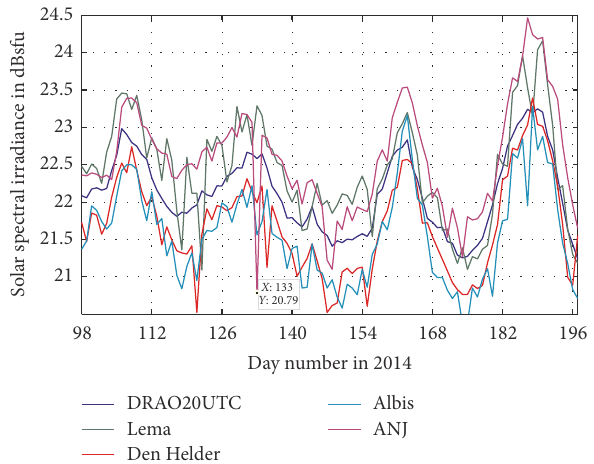
Figure 1: Daily variability of the horizontal polarization solar radio emission retrieved from four C-band weather radars in Europe from April 8 to July 16, 2014. The values from DRAO (20 UTC) are plotted forreferencepurposes:DRAOmeasurementsareacquiredatS-band using a 1-hour integration period and converted to C-band using (1).